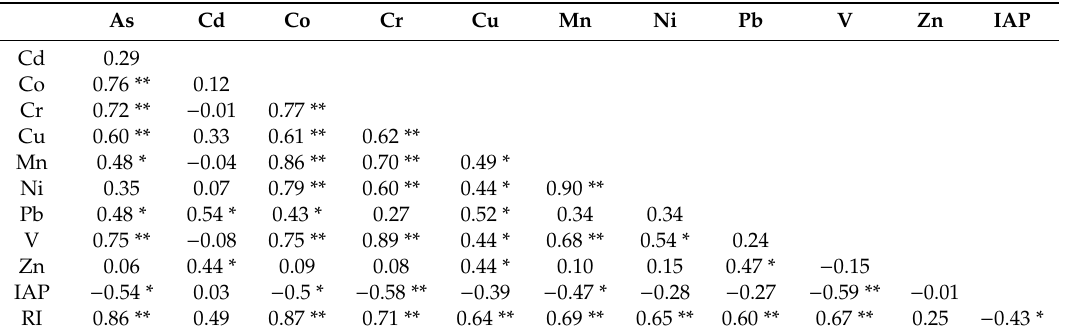
Table 3. Correlations of trace elements in Haplocladium angustifolium , the index of atmospheric purity (IAP), and potential ecological risk index